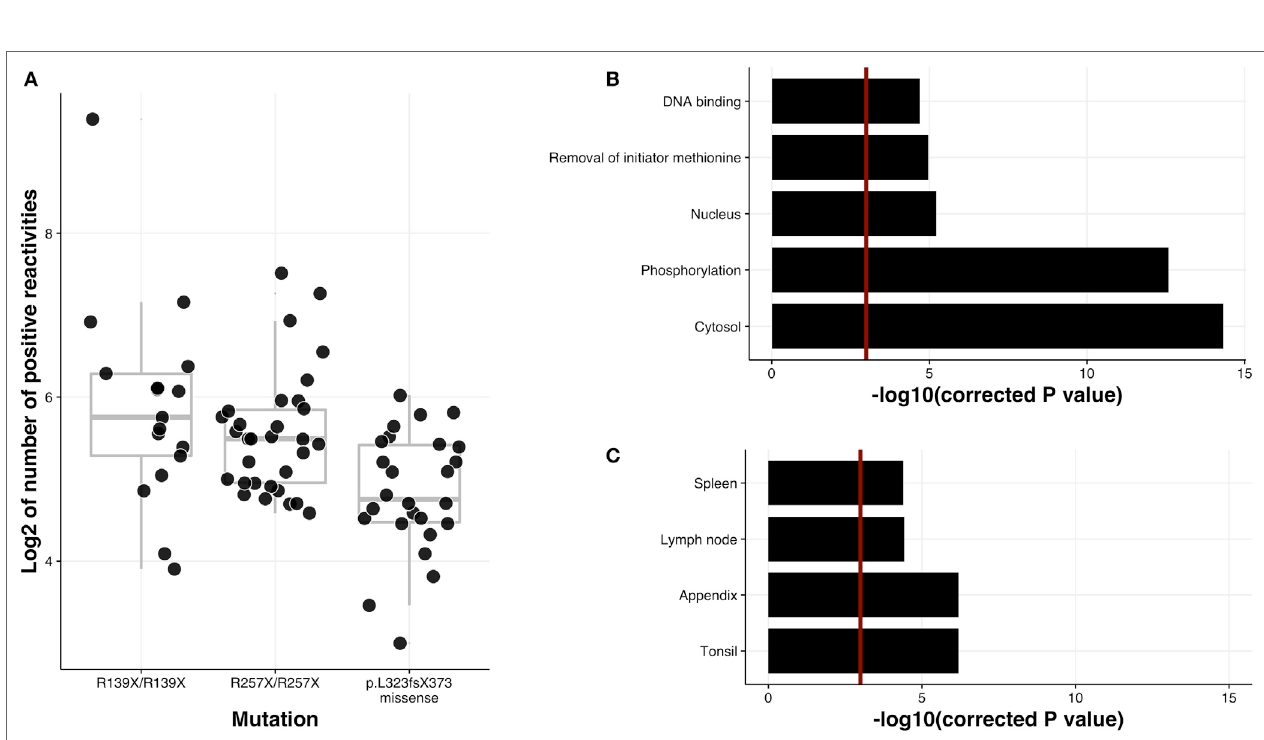
FigUre 5 | Autoantibody correlation with APECED mutations and enrichment analysis for protein characteristics. (a) Correlation of the number of autoantibody targets with APECED mutations using pairwise comparisons with Tukey and Kramer (Nemenyi) test and Tukey-Dist approximation for independent samples. The first and the second mutation types are significantly different from the third type in terms of log2 of positive hits with p -values 0.0016 and 0.0072, respectively. (B) Association of autoantigens with different protein characteristics. Length of each bar is directly proportional to the significance of the term, calculated with hypergeometric test. False discovery rate was used to correct for multiple testing. Red line is drawn at 0.05 significance level. (c) Association of positive reactivities with tissue-specific gene groups from Human Protein Atlas. Hypergeometric test was used to compute displayed p -values and false discovery rate was used to correct for multiple testing.